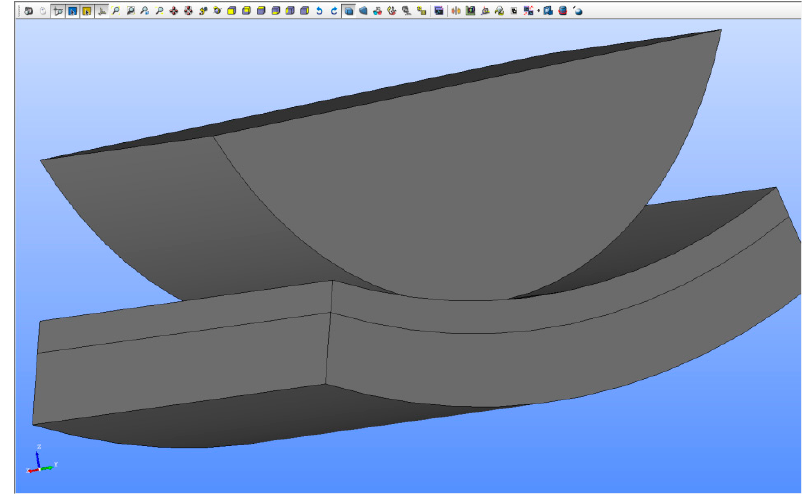
Figure 7. System CAD model—side surface of regenerator batch not worn.